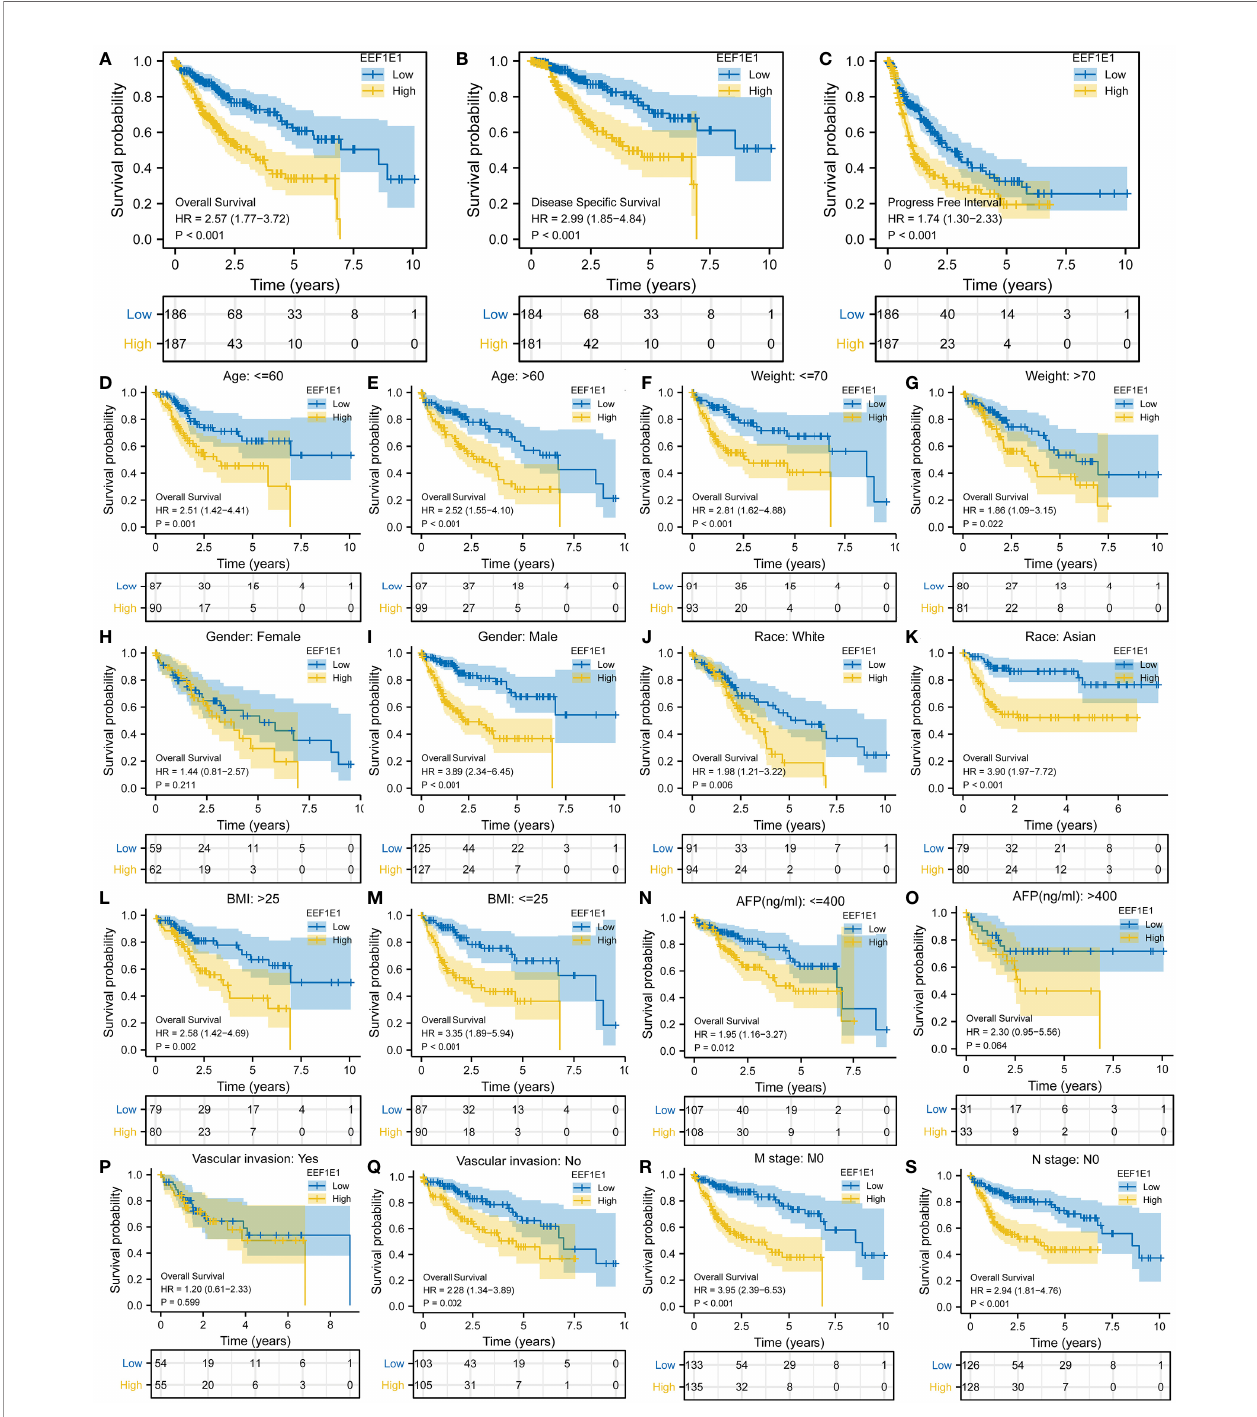
FIGURE 3 | Correlation between EEF1E1 expression and prognosis. (A) Effect of differential EEF1E1 expression on overall survival. (B) Effect of differential EEF1E1 expression on disease speci fi c survival. (C) Effect of differential EEF1E1 expression on overall progress free interval. (D, E) Effect of differential EEF1E1 expression and age on overall survival. (F, G) Effect of differential EEF1E1 expression and weight on overall survival. (H, I) Effect of differential EEF1E1 expression and gender on overall survival. (J, K) Effect of differential EEF1E1 expression and race on overall survival. (L, M) Effect of differential EEF1E1 expression and BMI on overall survival. (N, O) Effect of differential EEF1E1 expression and AFP level on overall survival. (P, Q) Effect of differential EEF1E1 expression and vascular invasion on overall survival. (R) Effect of differential EEF1E1 expression and M stage on overall survival. (S) Effect of differential EEF1E1 expression and N stage on overall